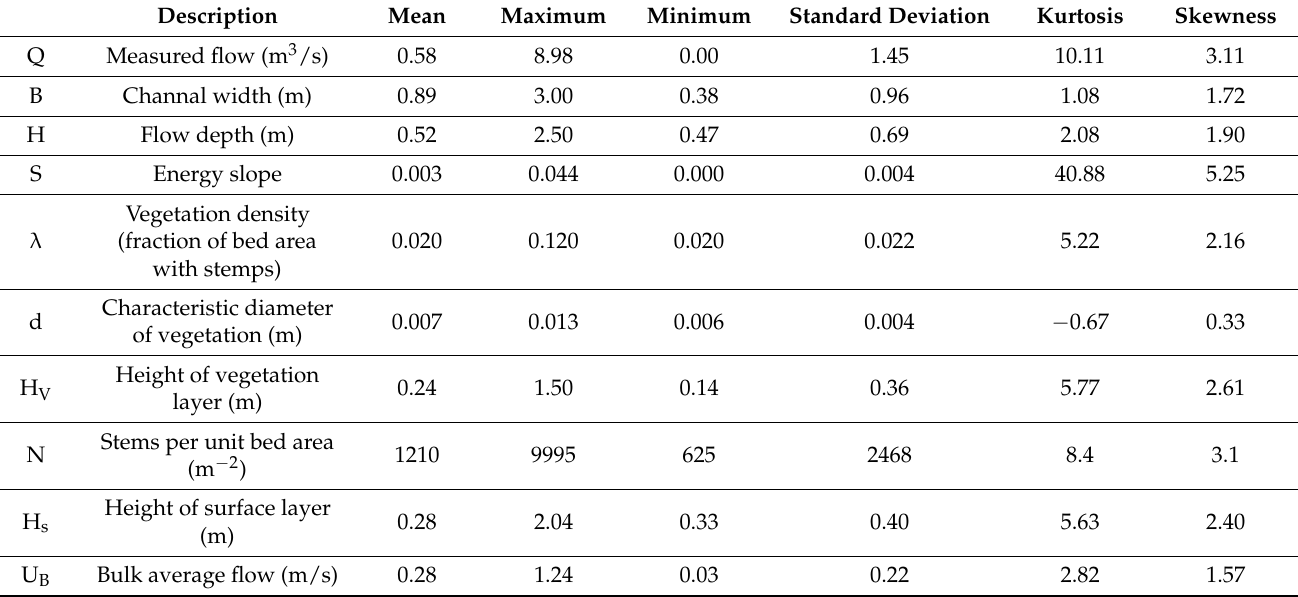
Table 1. Descriptive statistics of the data